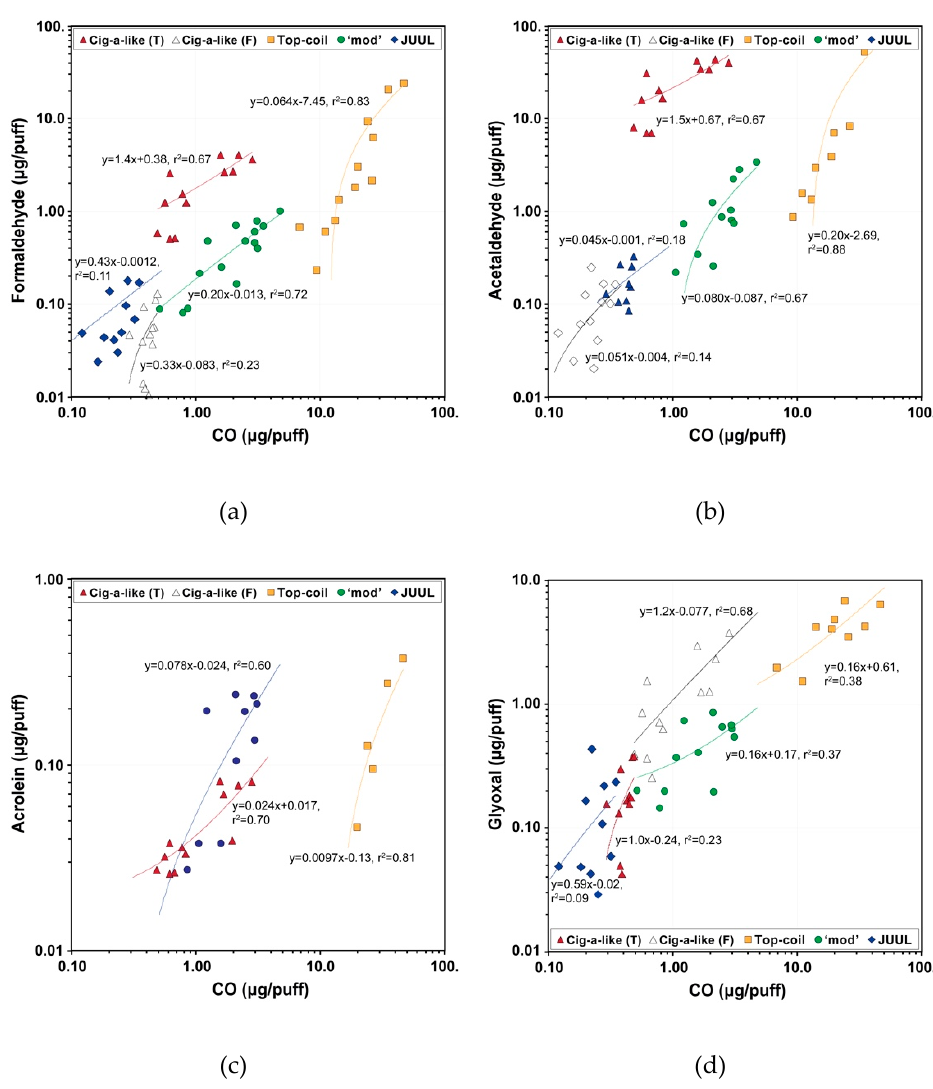
Figure 5. Relationship between CO and ( a ) formaldehyde, ( b ) acetaldehyde, ( c ) acrolein, and ( d ) glyoxal in e-cigarette aerosols. Cig-a-like e-cigarette was tested using tobacco (T) and grape (F) flavored e-liquids. Fruit flavored e-liquids were used for top-coil, ‘mod’, and JUUL e-cigarettes. Table 2. Correlation coefficients of CO and carbonyl compounds in e-cigarette aerosols. Asterisk marks (*) indicate Pearson’s correlation coefficients with statistical significance ( p < 0.05).